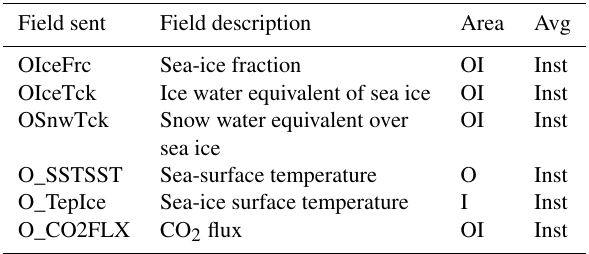
Table A2. Fields sent from CanNEMO to CanCPL. Descriptions are as in Table A1.